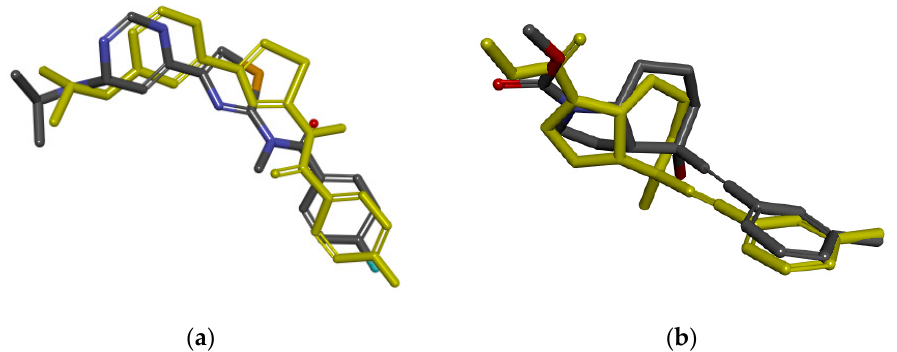
Figure 6. The comparison between the initial binding pose (yellow) and the docked pose. ( a ) mGluR1; ( b ) mGluR5. Table 9. The identification and rationality of the allosteric active pocket.